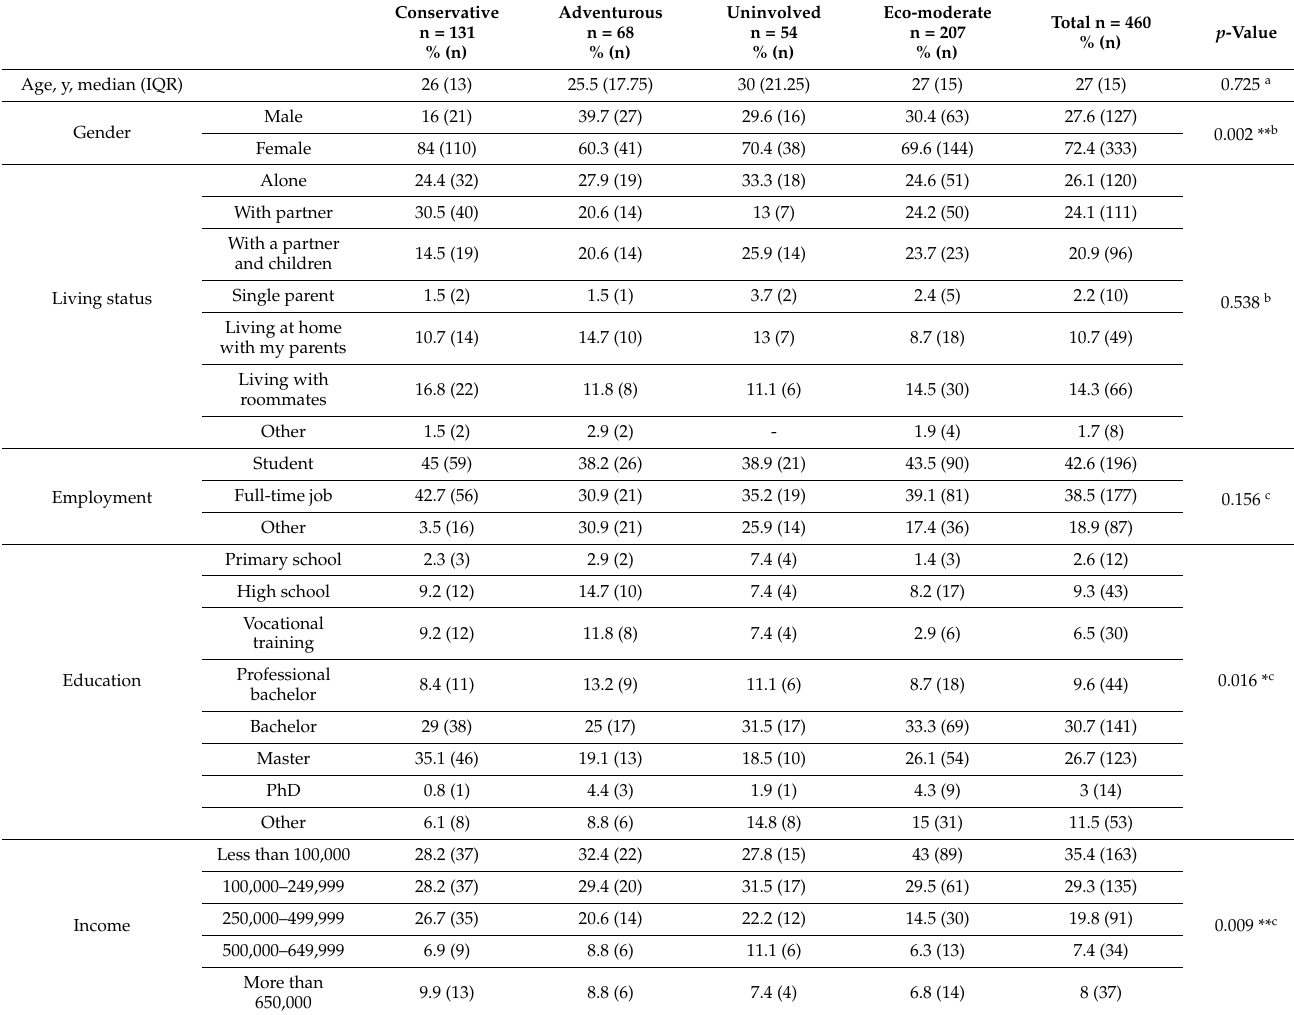
Table 3. Sociodemographic and lifestyle factors of the four segments and their